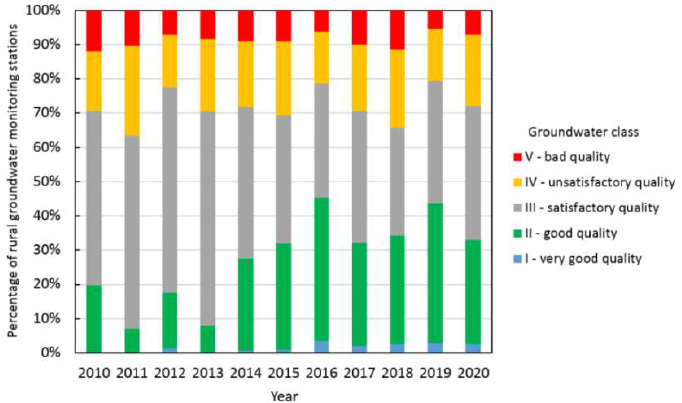
Figure 1. Results of groundwater monitoring quality in rural areas in Poland, period 2010–2020, based on [36], groundwater quality classes according to [34,35].